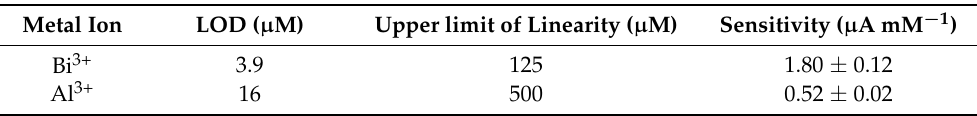
Table 3. Analytical data collected from Dixon plots obtained for Bi 3+ , Al 3+ ion in presence of 20 mM of glucose.